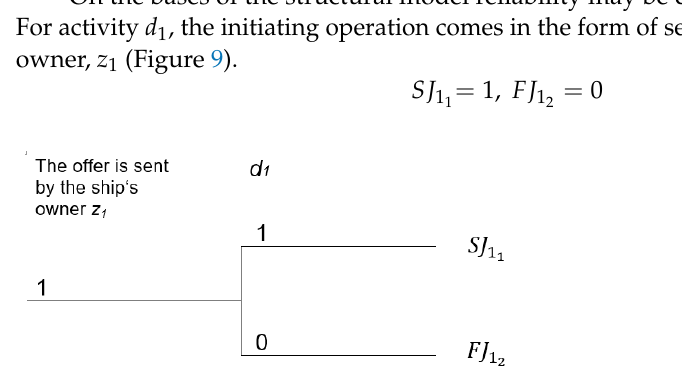
Figure 8. Structural diagram of the cargo handling process at the container terminal.